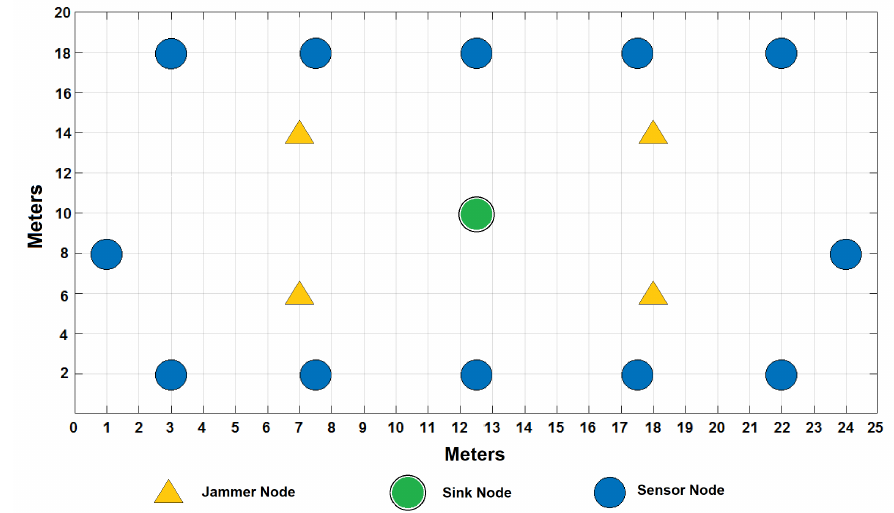
Figure 6. Distribution of the WSN nodes of the real experiment.